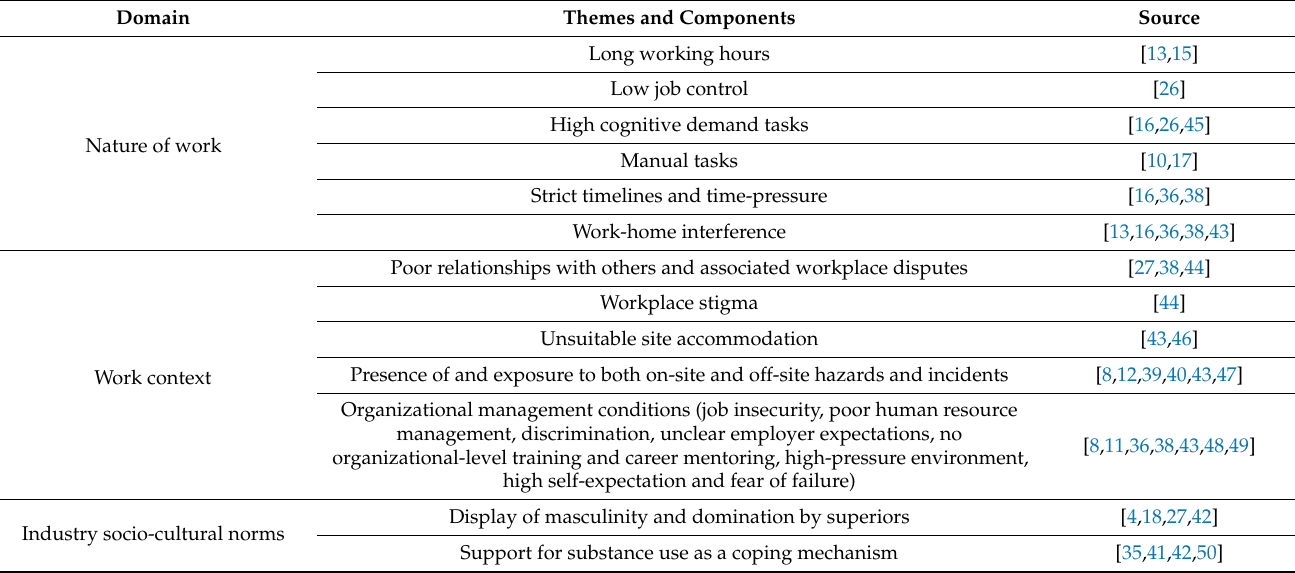
Table 4. Young construction workers’ organizational/industrial psychosocial risk